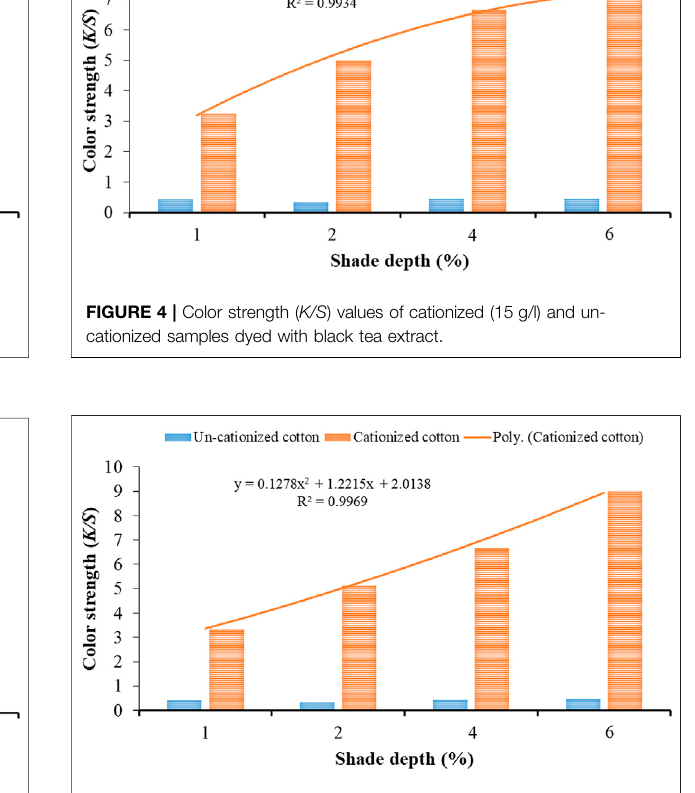
FIGURE 5 | Color strength ( K/S ) values of cationized (20 g/l) and un- cationized samples dyed with black tea extract.